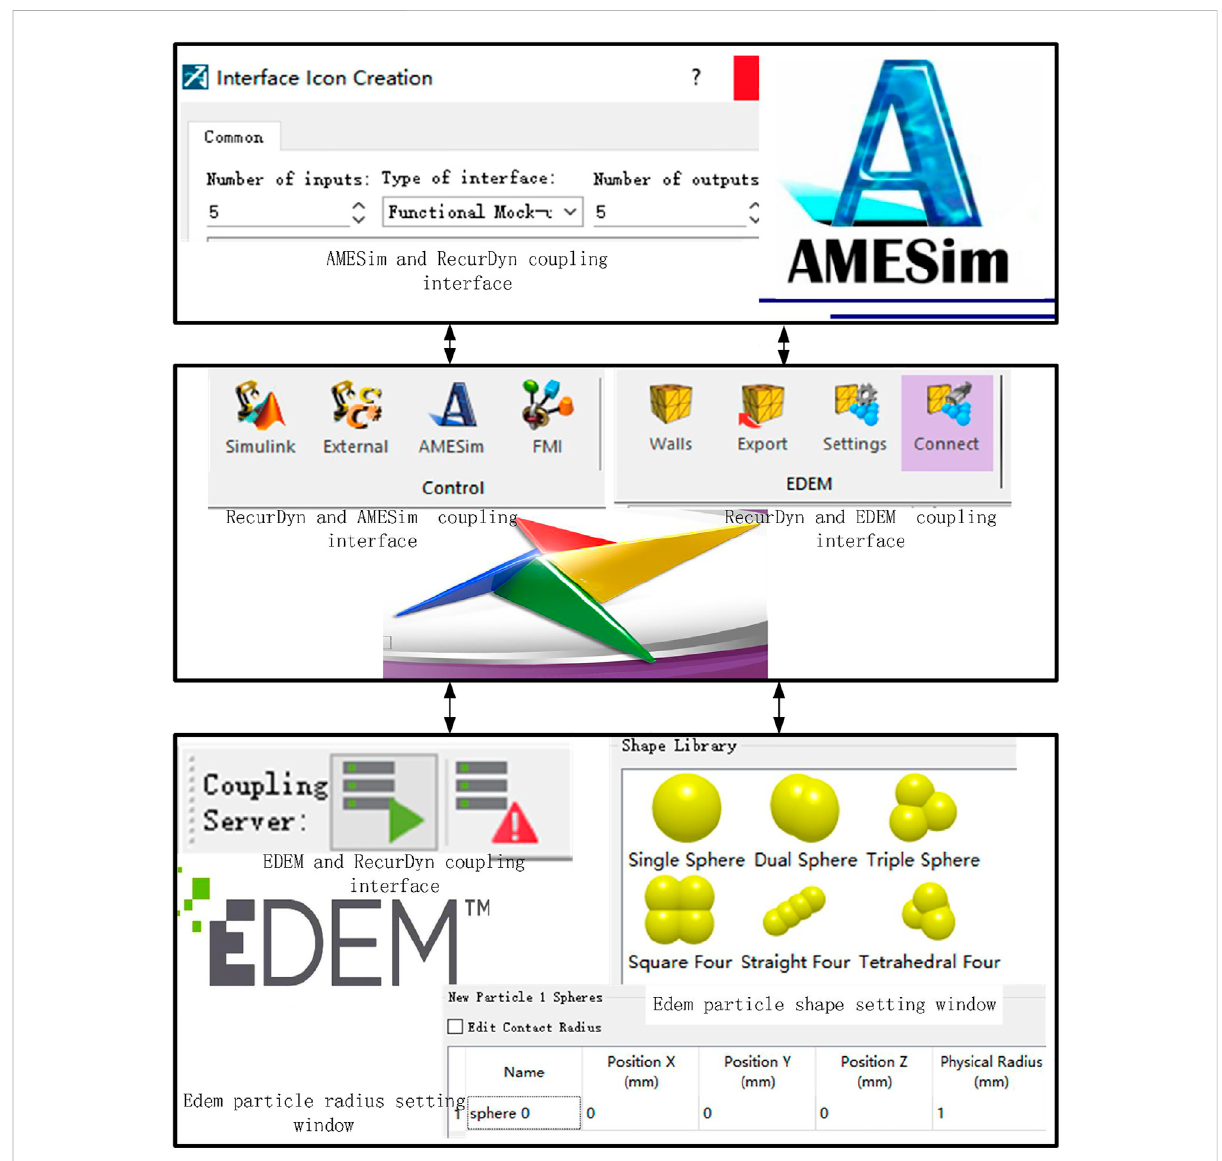
FIGURE 8 Multi-domain collaborative simulation